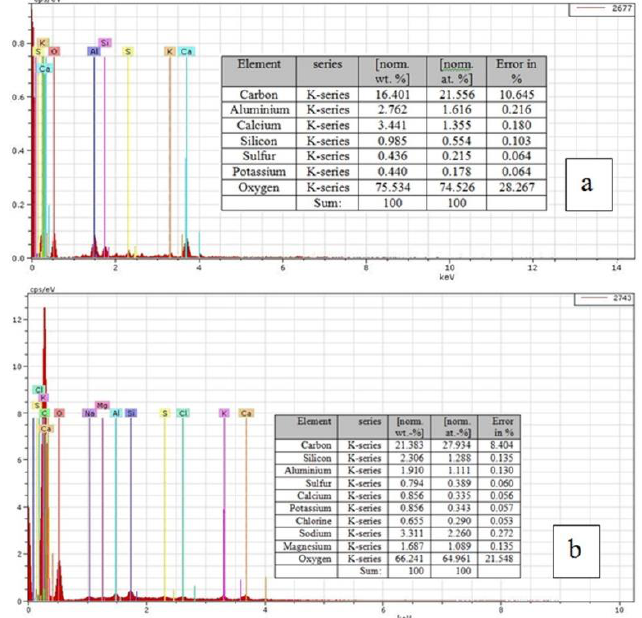
Figure 9. EDX spectra and elemental composition: ( a ) new varnish; ( b ) old varnish.